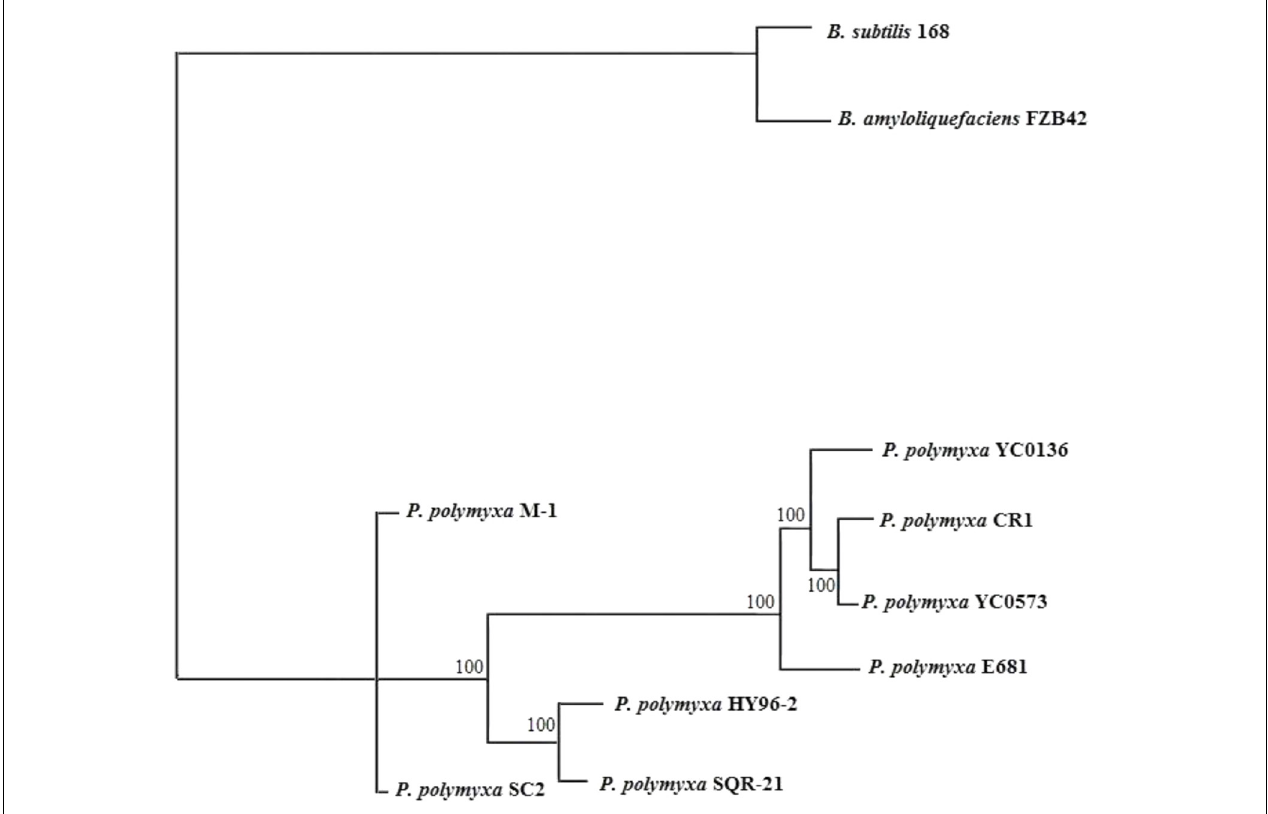
FIGURE 3 | Phylogenetic tree for P. polymyxa HY96-2 and the seven other P. polymyxa strains, B. subtilis 168, and B. amyloliquefaciens FZB42 based on homologous